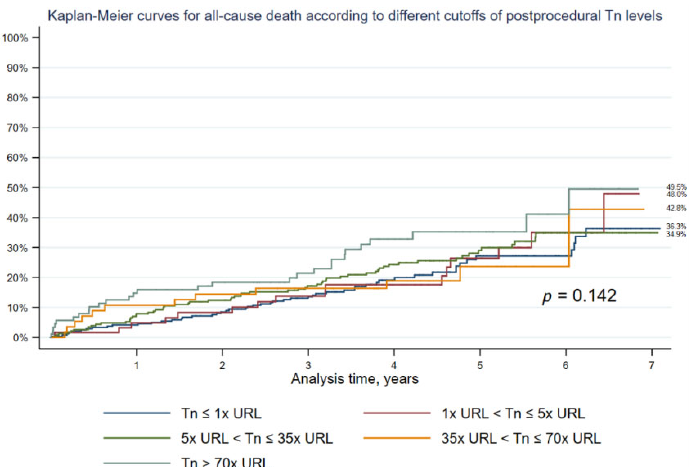
Figure 4. Kaplan-Meier curves for all-cause mortality according to different cutoffs of postprocedural Troponin levels.